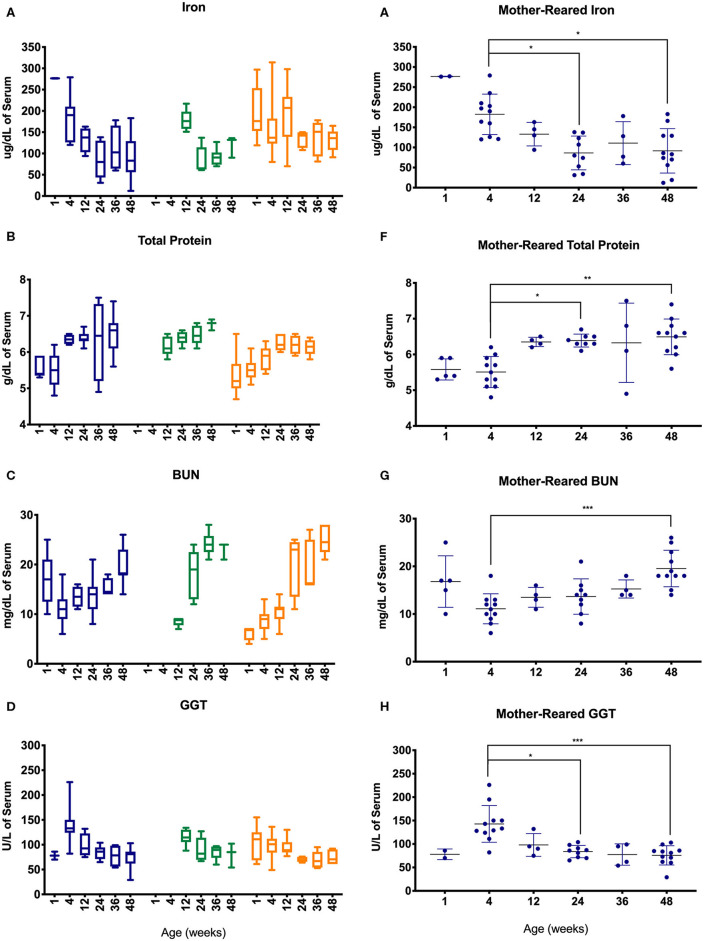
Trends in blood chemistry values in pediatric animals through the first year of life. Age binning was completed for samples from animals with average ages of 1 week (0–2 weeks old), 4 weeks (3–5 weeks old), 12 weeks (11–13 weeks old), 24 weeks (22–26 weeks old), 36 weeks (34–38 weeks old), and 48 weeks (46–50 weeks old). Data were shown for iron (A), total protein (B), BUN (C), and GGT (D) from the Colony MR (blue), Colony NR (green), and Research NR (orange). (A–D) were plotted using box and whiskers depicting median, minimum and maximum values and (E–H) applied statistical analyses of results (mean ± st. dev.) from the Colony MR animals using Kruskal-Wallis test coupled with Dunn's multiple comparisons to illustrate how CBC parameters vary with age. *P < 0.05; **P < 0.01; ***P < 0.001.